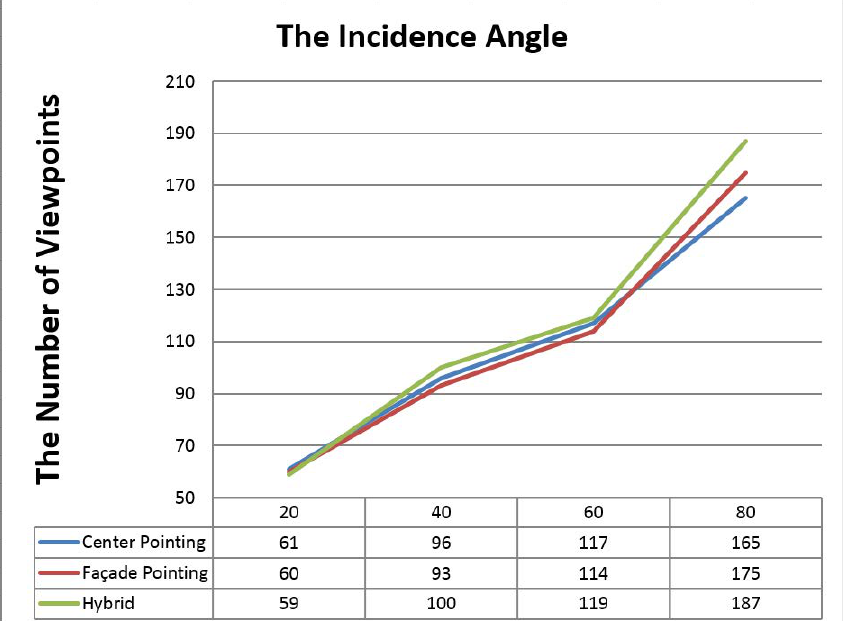
Figure 10. The number of viewpoints for the centre, façade and hybrid pointing imaging network design in different setting of incidence angles (20, 40, 60 and 80 degrees).